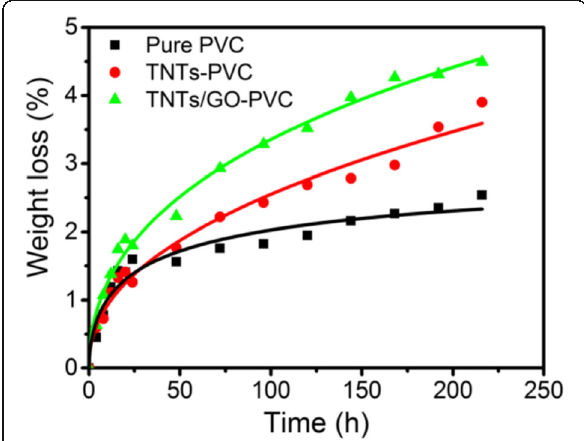
Fig. 10 Weight loss of pure PVC and PVC-matrix nanocomposite films under UV-light irradiation (40% humidity). Incorporated TNTs/ GO to PVC could accelerate the photo degradation of PVC. The large interfacial contact surface area and strong interaction between TNT